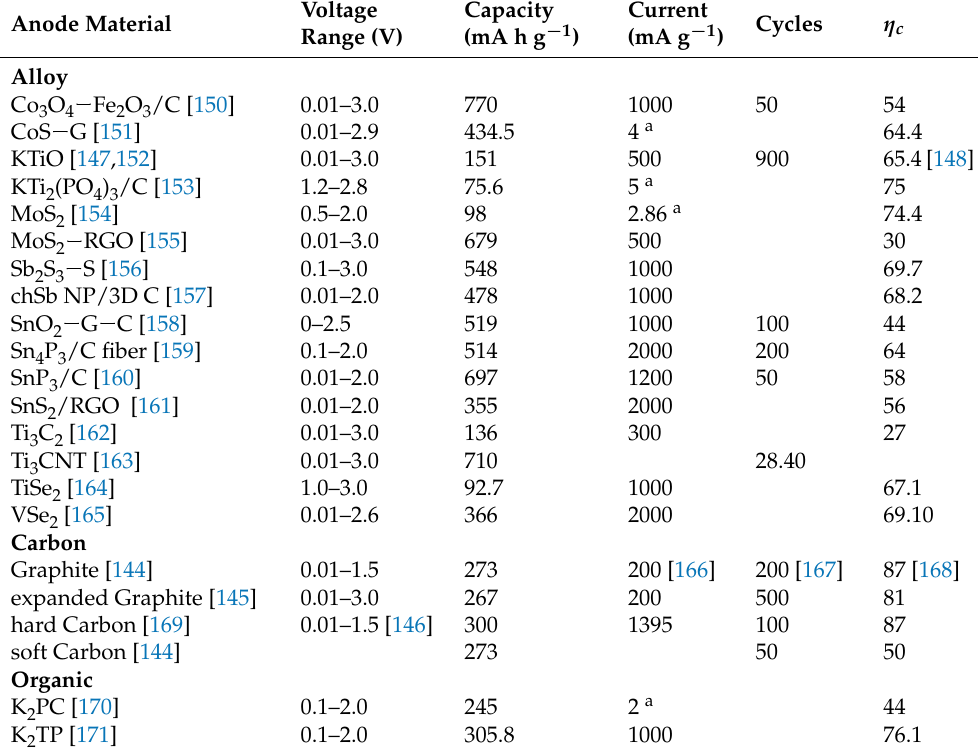
Table 4. Anode materials for K-based